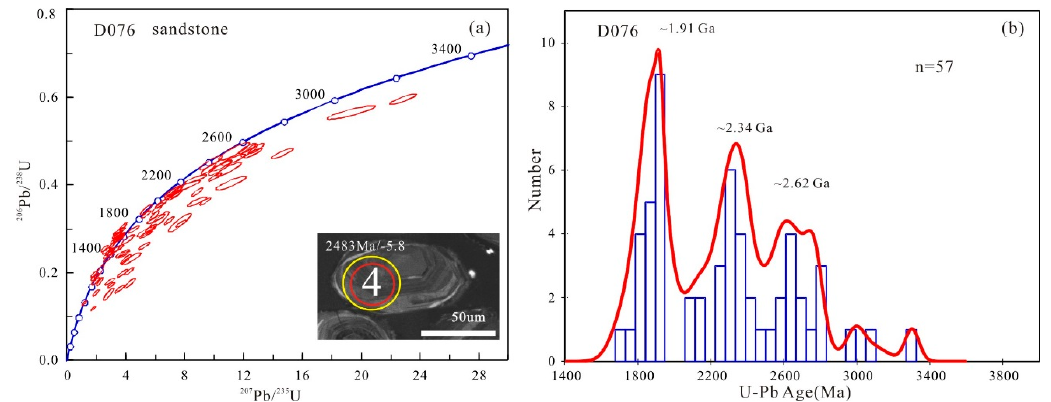
Figure 6. CL images and concordia plots ( a ) and statistical distribution ( b ) of zircon U–Pb dating for sandstone (D076) of DCG.